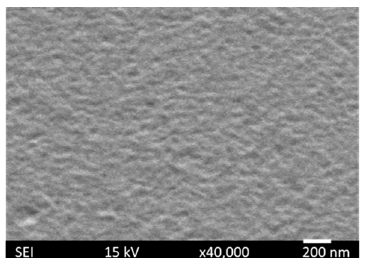
Figure 3. Surface morphology from SEM images of samples after each step: ( a ) as ‐ deposited ( pTi ), ( b ) as ‐ anodized ( aTiO 2 ), and ( c ) as ‐ ultrasonicated ( cTi ). The SEM image of the boundary line of the ultrasonicated area clearly shows that the process successfully removed the brittle, weakly adhered nanoporous TiO 2 without caus ‐ ing a significant modification of the remnant nanopatterned metallic titanium layer (Fig ‐ ure 4).